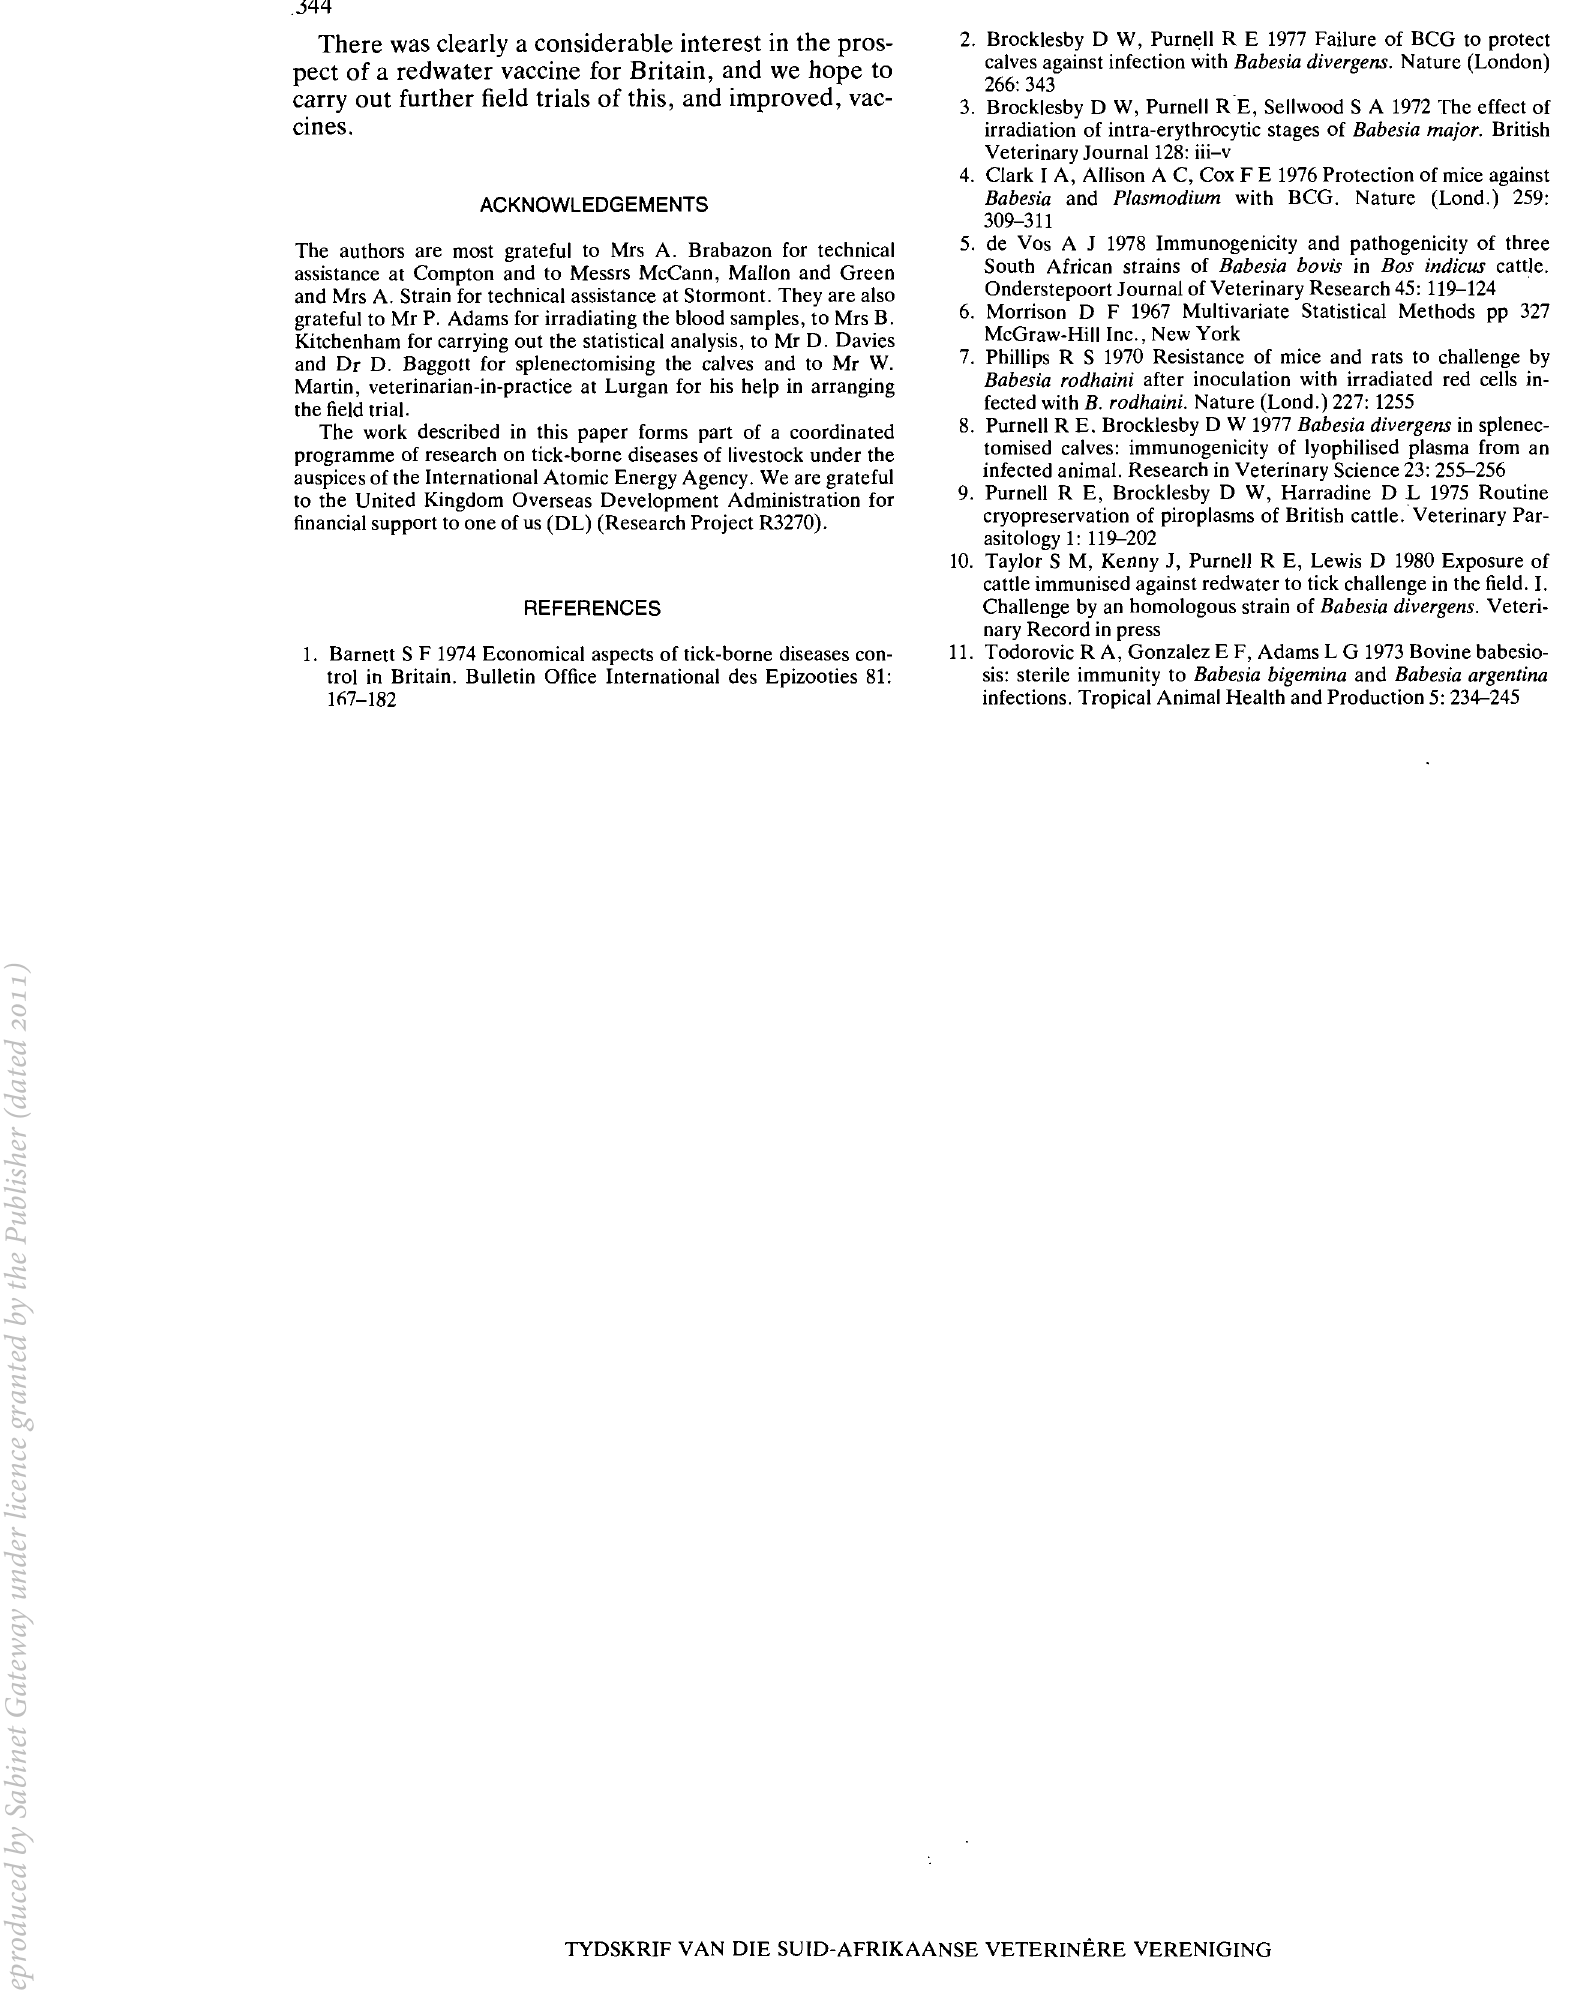
TYOSKRIF VAN DIE SUID-AFRIKAANSE VETERINERE